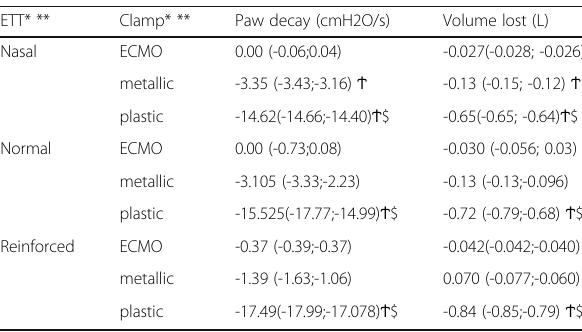
Table 1 (abstract 000282). Decay in Paw and volume lost 5 seconds after disconnection of ETT once clamped across ETT and clamps